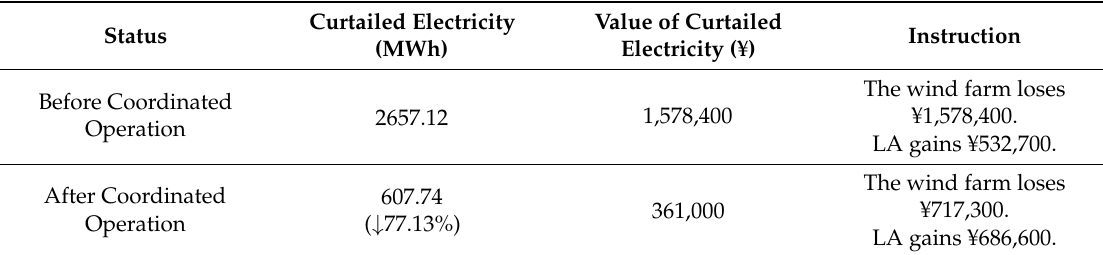
Table 5. Revenues comparison between wind farm and load aggregator (LA) before and after coordinated